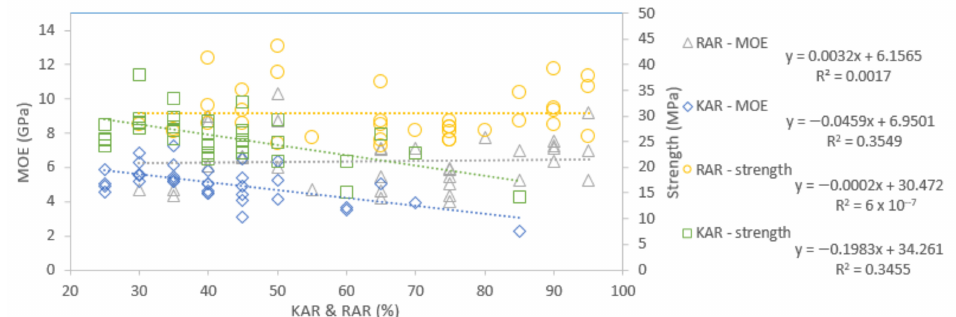
Figure 15. KAR and RAR vs. CParG MOE and